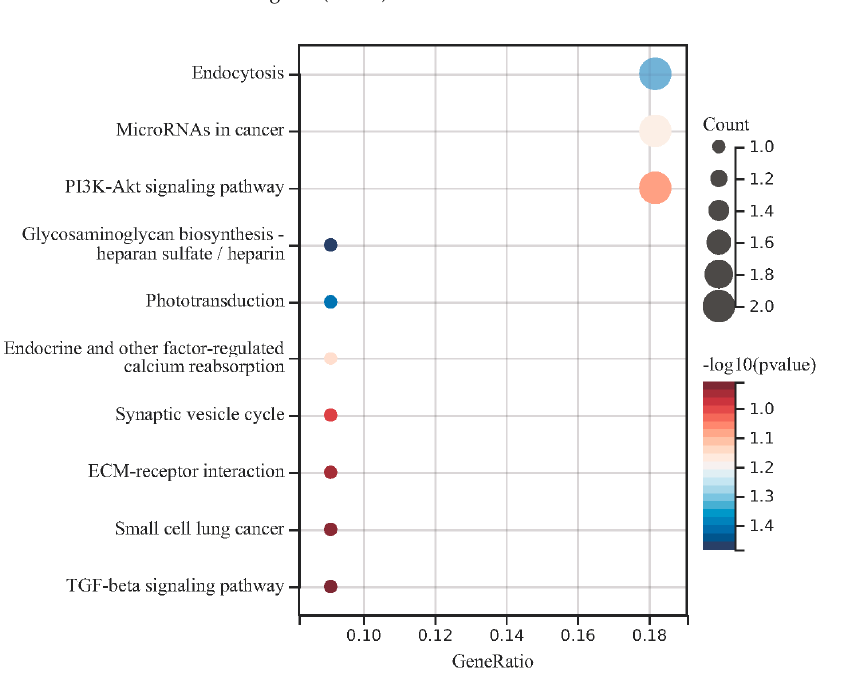
Figure 5. Enrichment analysis for the target genes in the regulatory networks. The KEGG enrichment analysis results were sorted according to the p value, and the darker red color indicated that the smaller the p value, the higher the enrichment degree.